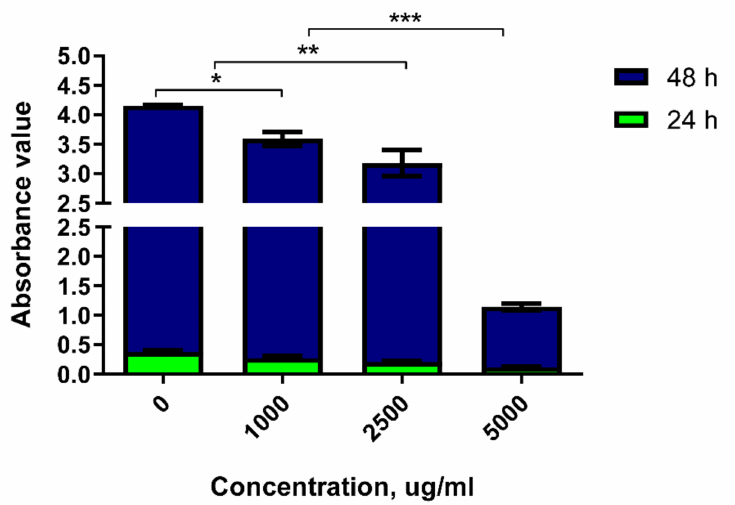
Figure 13. The toxicity of DRF3 on MCF-7 cells at different concentrations (the results were repeated three times, shown as mean ± SEM; * means significant differences p < 0.05; ** means significant differences p < 0.01; *** means significant differences p <